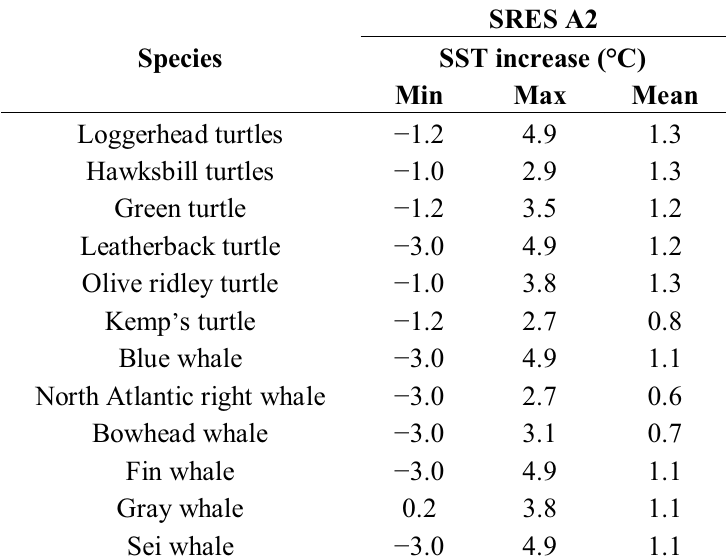
Table 5. Projected changes in sea surface temperatures (SST) in species (cid:182) distribution range (marine